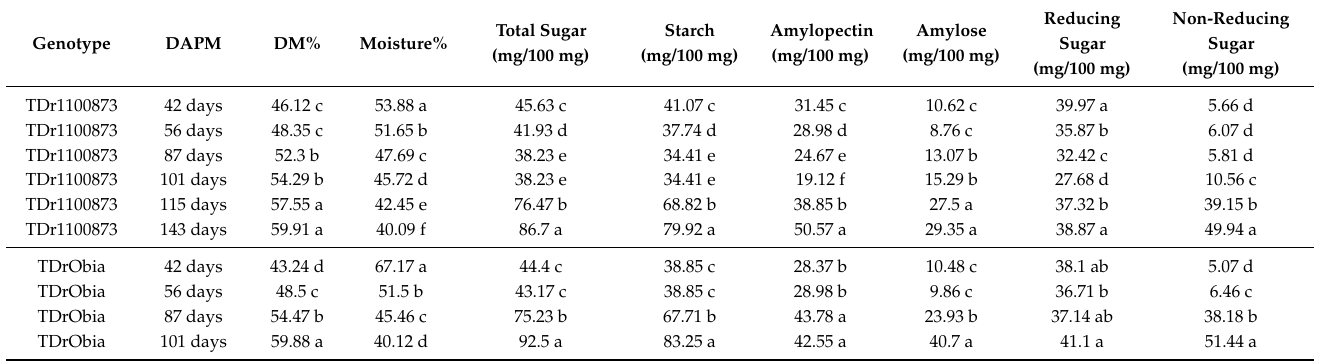
Each variable was analyzed separately for each variety. Means were compared across the sampling points in days after physiological maturity at p ≤ 0.05. Pairwise means comparison was performed using Duncan’s post hoc test, and variables with the same letter were not significantly different at p = 0.05. TDrObia stands for